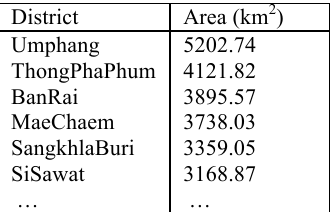
Table 1. Simple data input of district name and area in square